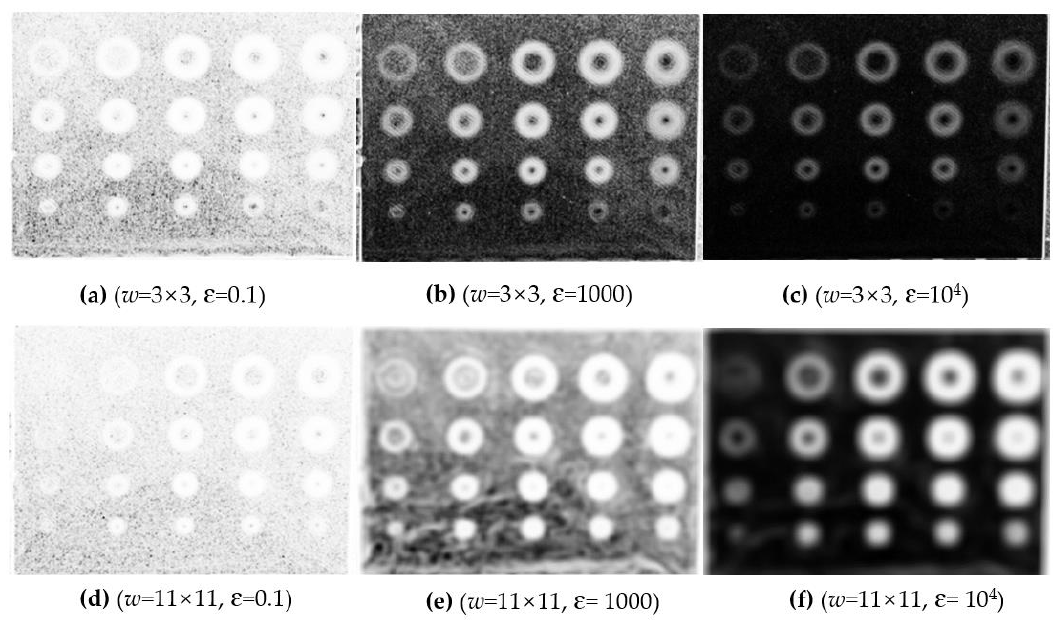
Figure 5. Coefficient images a w with different subset windows and ɛ . Figure 5. Coe ffi cient images a w with di ff erent subset windows and ε . Table 4. Comparison of the CPP Indices with Di ff erent Parameter